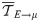
Transfer entropy rates T¯E→μ and T¯μ→E in the low IPTG experiment.(a) Original model of Ref. [4] (b) Modified model where NE is a white noise. The symbols are the estimates from the inference method when varying the sampling time τ, and the solid lines are the theoretical predictions from Eq (13) in (a) and from Eq (60) in (b). Note that T¯μ→E diverges as τ goes to zero in (a) but not (b).